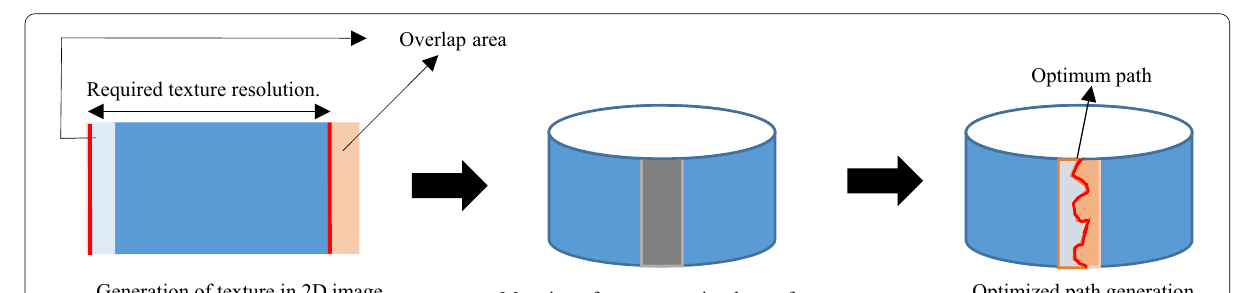
Required texture resolution.